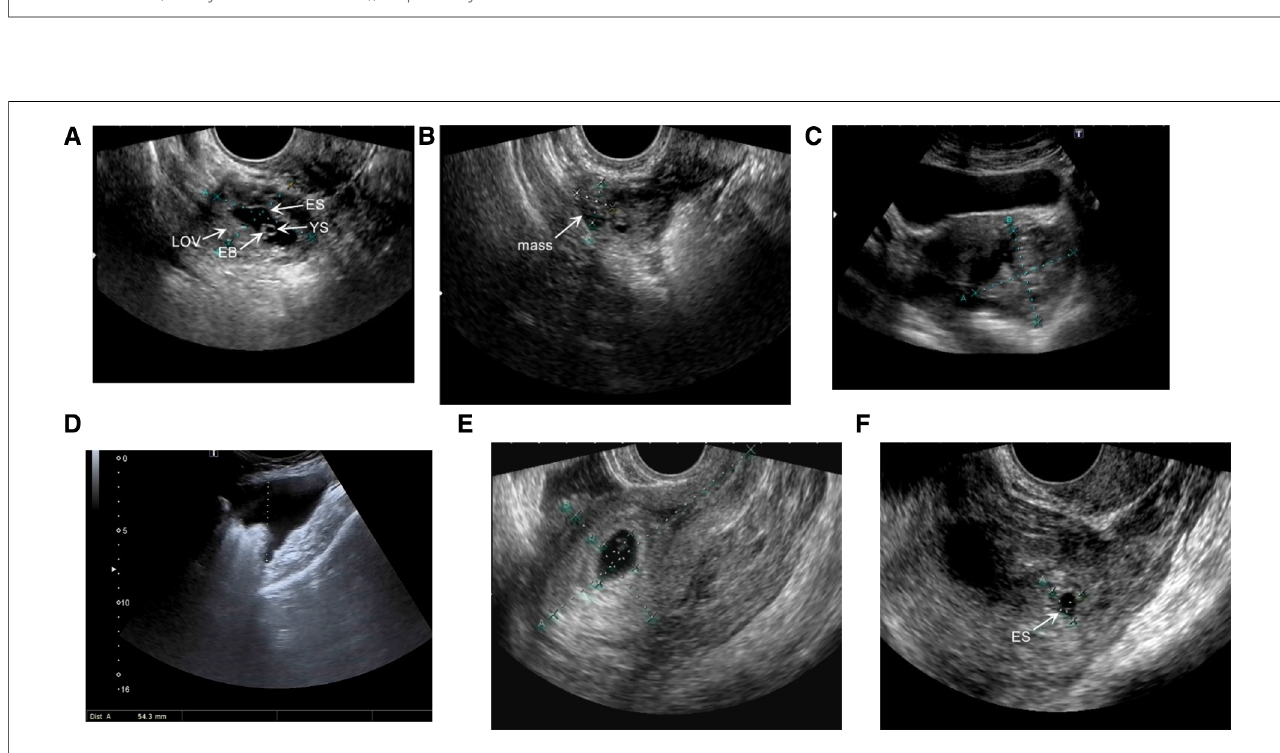
FIGURE 2 Ultrasound images showing several types of ovarian pregnancy. ( A ) Gestational sac type: ovarian tissue (LOV) can be seen surrounding the embryo sac (ES). The yolk sac (YS) and embryo bud (EB) are located in the ES. ( B ) Hematoma type I: a mixed echoic mass approximately 2.1×2.3×1.9 cm in size. ( C ) Hematoma type II: a mixed echoic mass approximately 6.0×5.3 cm in size. ( D ) Intraperitoneal hemorrhage type: 5.4 cm deep pelvic effusion. ( E, F ) An ovarian pregnancy patient complicated with intrauterine pregnancy. ( E ) The intrauterine embryo sac. ( F ) ES in the adnexal